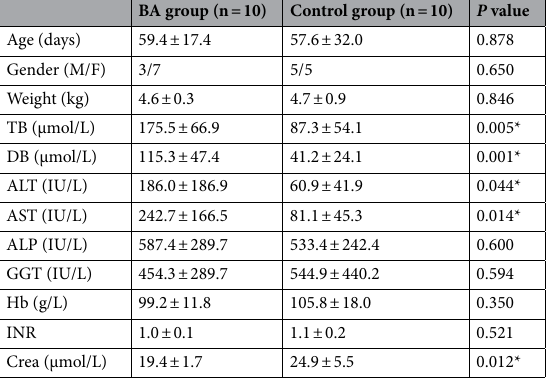
Table 1. General information and laboratory test results of children enrolled in the clinical study. TB total bilirubin, DB direct bilirubin, ALT alanine aminotransferasem AST aspartate transaminase, ALP alkaline